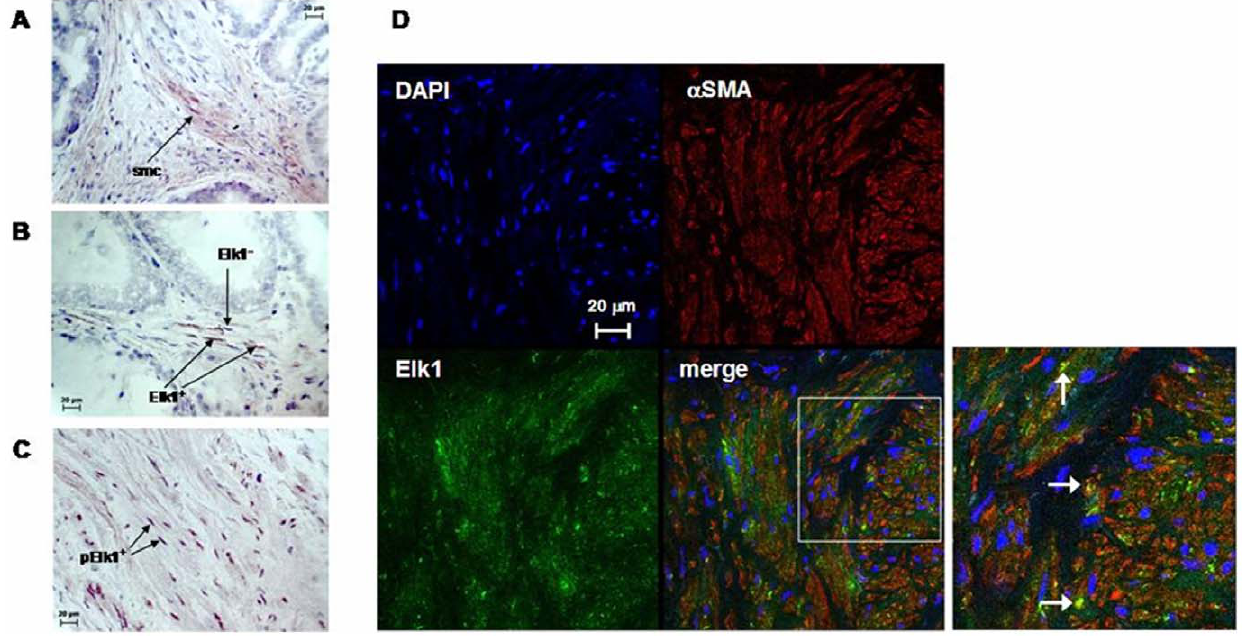
Figure 1. Elk1 expression in human prostate tissue. ( A ), ( B ) Peroxidase staining of prostate tissues for Elk1. ( A) Cytosolic Elk1 immunoreactivity in smooth muscle cells (smc). ( B ) Elk1-positive (Elk1 + ) and –negative (Elk1 2 ) nuclei. ( C ) Peroxidase staining of prostate tissue for phospho-Elk1, with phospho-Elk-positive (pElk1 + ) nuclei. ( D ) Double fluorescence staining of human prostate tissue for Elk1 and a SMA. Yellow color in merged pictures represents Elk1 expression in smooth muscle cells. Shown are representative pictures from stainings from tissues of n=6 patients for each staining.